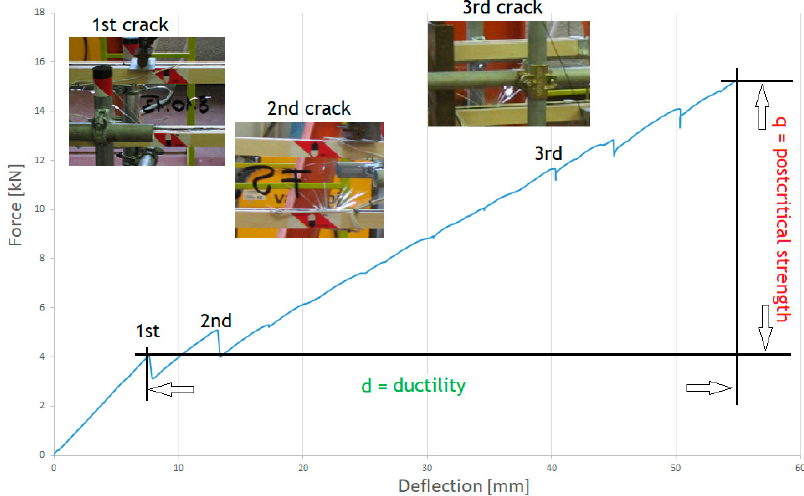
Figure 19. Force versus vertical beam displacement for TGIB with annealed float glass.